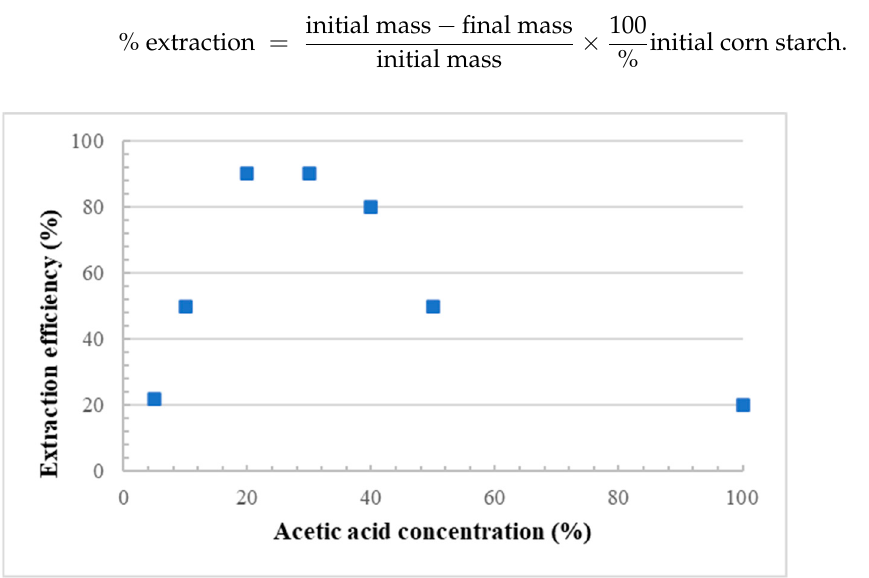
Figure 2. Corn starch extraction efficiency as a function of acetic acid concentration.